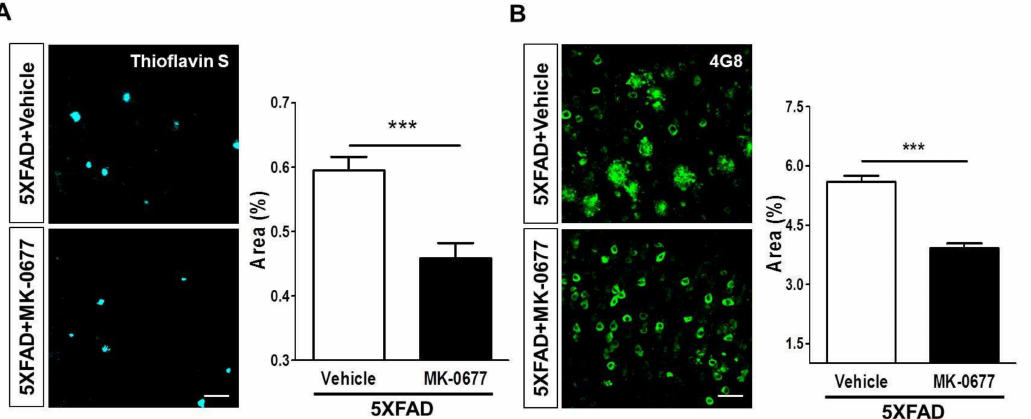
Figure 2. MK-0677 treatment significantly reduced A β plaques in the deep cortical layers of 5XFAD mice. The burden of A β was estimated by thoflavin-S staining and immunohistochemical staining for the 4G8 antibody. 5XFAD mice treated with MK-0677 ( n = 6) showed a decreased positive area (%) in both thioflavin-S ( A ) and 4G8 ( B )-stained brains, compared with vehicle-treated 5XFAD mice ( n = 7). *** p < 0.001 indicates significant differences between the groups. Scale bar = 50 µ